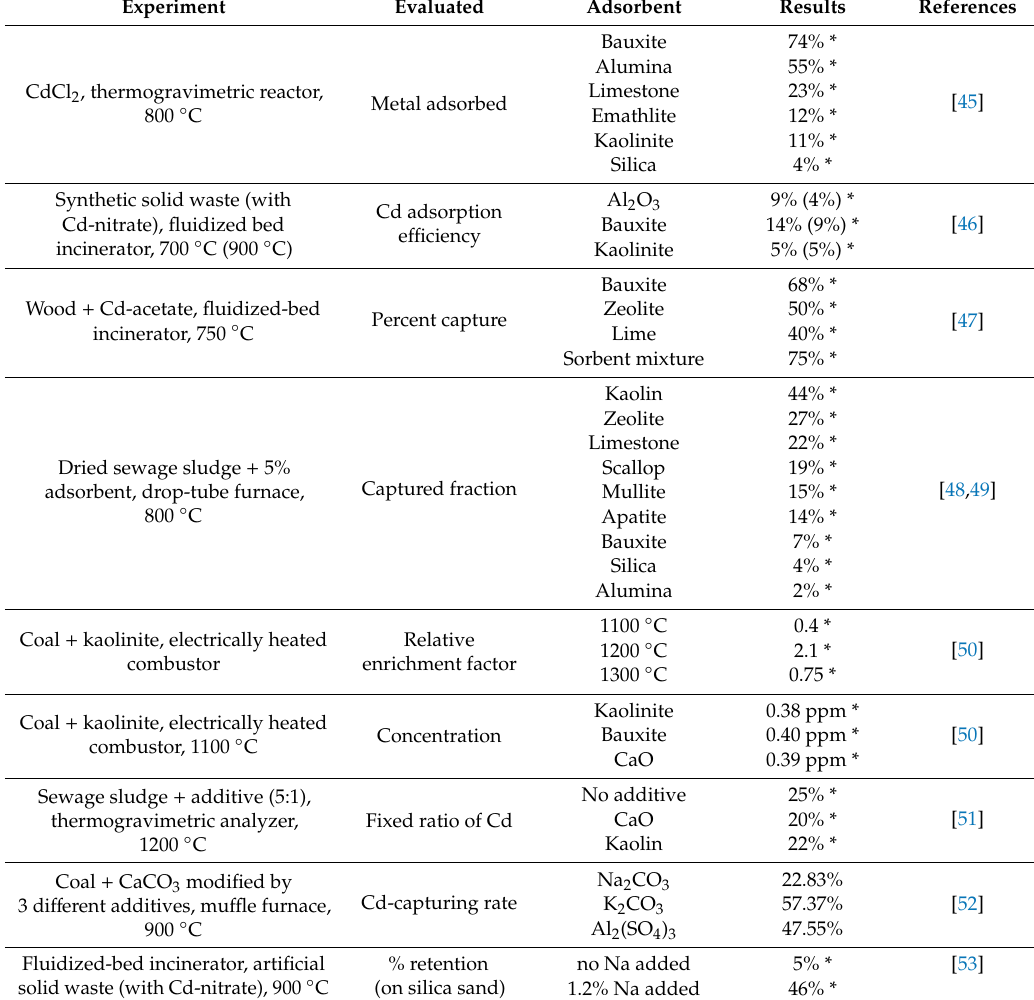
Table 3. E ff ect of adsorbents on Cd